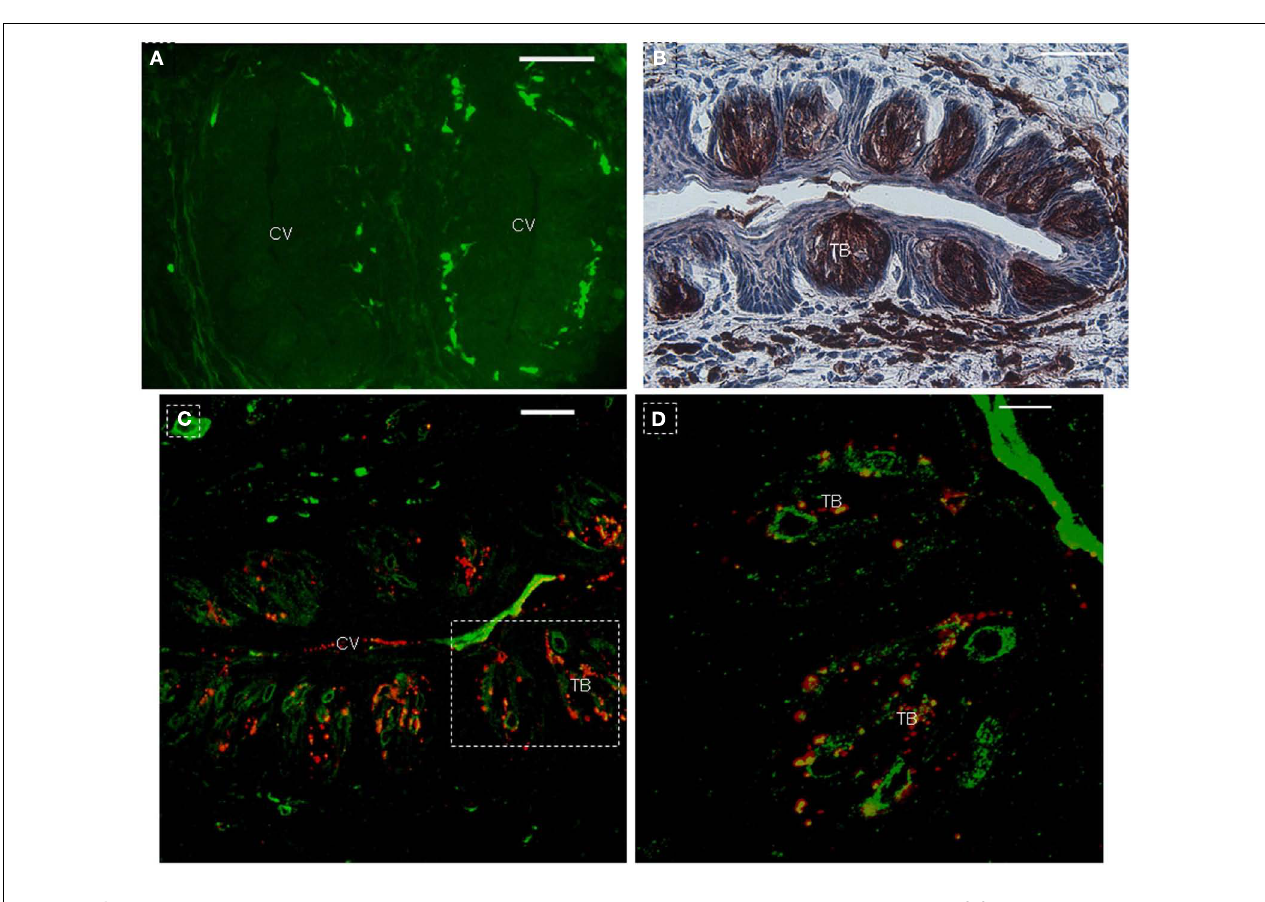
FIGURE 4 | Co-expression of GFP with GLAST in taste buds after 10days of Dox induction. (A) Immunohistochemistry with anti-NTPDase2 showed the expression of NTPDase2 in taste buds and connective tissue around CV papillae. (B) After 10days Dox induction,